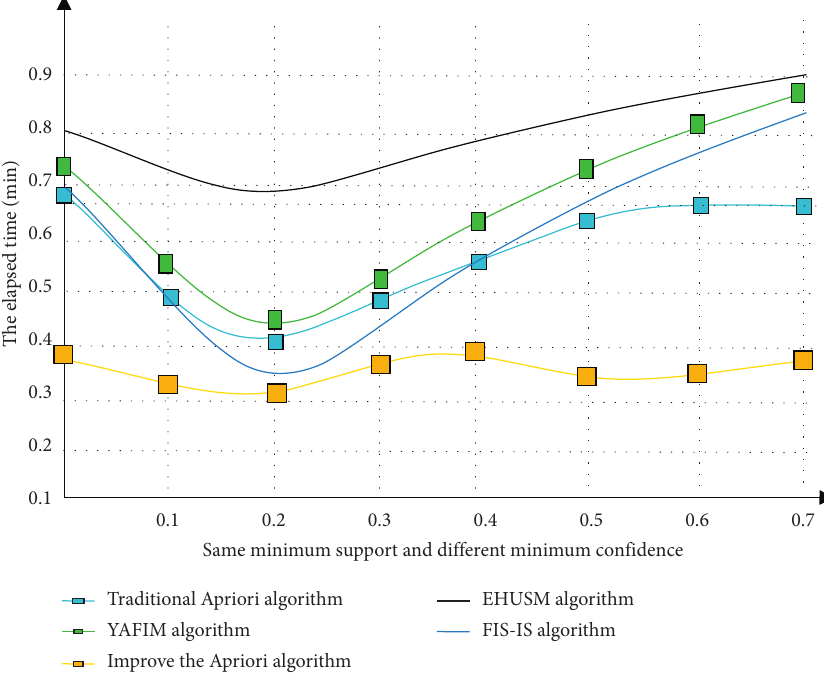
Figure 10: Comparison of algorithms with different confidence